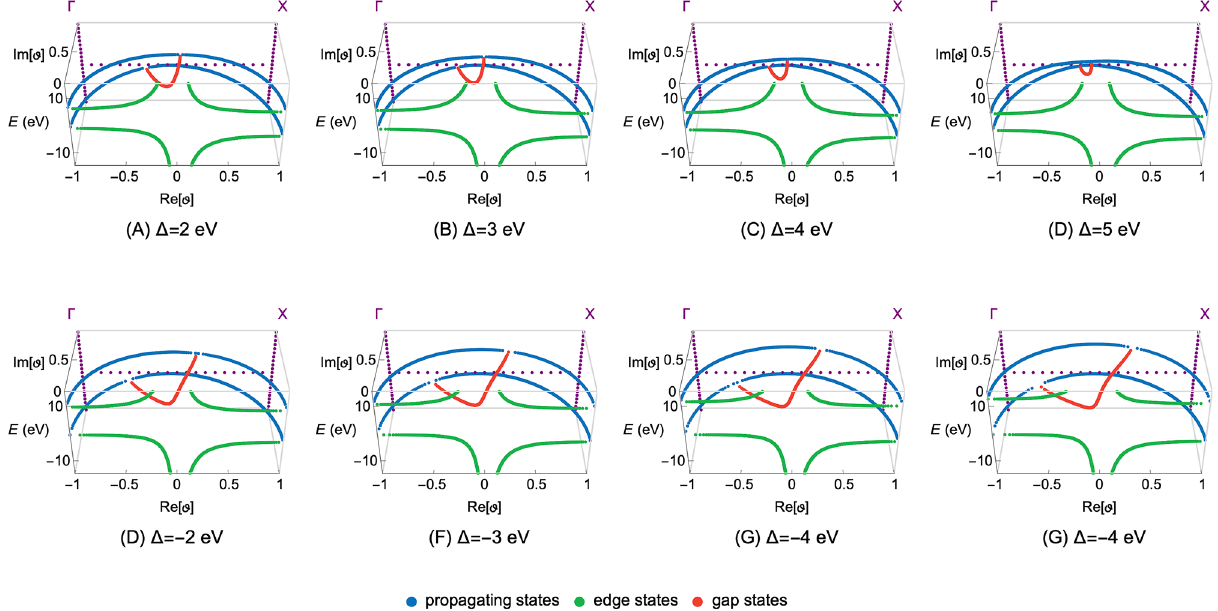
Figure 2. The complex band structures of the CsCl insulator in the complex plane of ϑ for the selected values of the onsite energy deviation ( (cid:31) ). The first row of the sub-figures ( A – D ) depicts solutions for the positive values of (cid:31) , whereas the second row ( E – H ) presents results obtained for the negative (cid:31) values. Note that for clarity we depict only solutions for Re distinguished by the blue, green and red color, respectively. Moreover, the zero energy level is set at the top of the valence